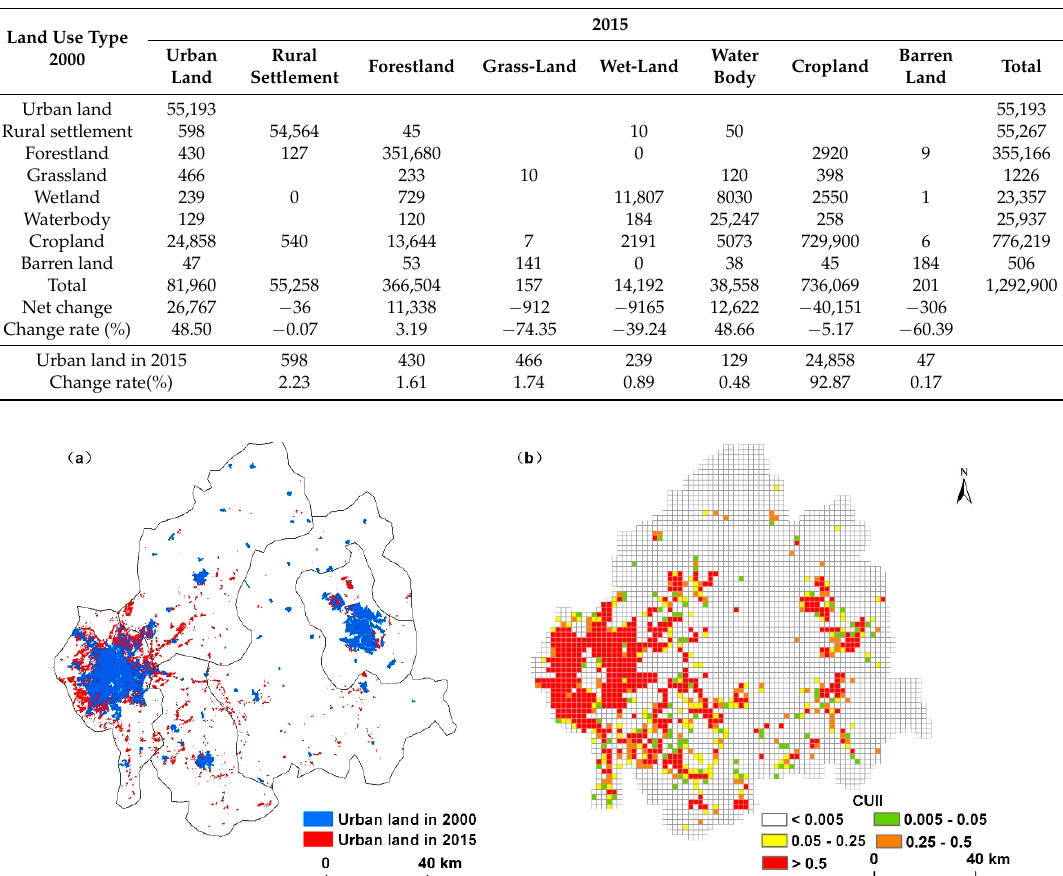
Table 5. The conversion matrix of land use types from 2000 to 2015 (ha).